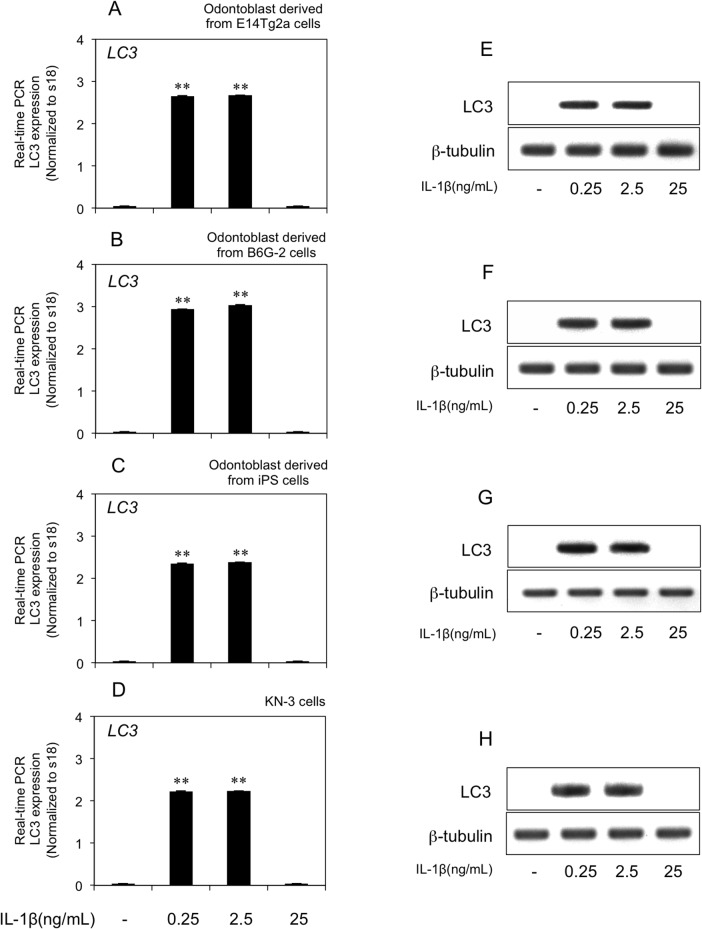
IL-1β-induced expression of LC3 mRNA and protein in odontoblast-like cells.Two stem cell-derived odontoblast-like cell lines and an odontoblast cell line (KN-3) were treated with IL-1β (0, 0.25, 2.5, and 25 ng/mL). (A–D) qPCR analysis of LC3 mRNA expression relative to the control (18S rRNA). Data are the means ± SD of four independent experiments. **P < 0.01. (E–H) Western blot analysis of LC3 and β-tubulin protein levels following stimulation with IL-1β. Representative blots of three independent experiments are shown.